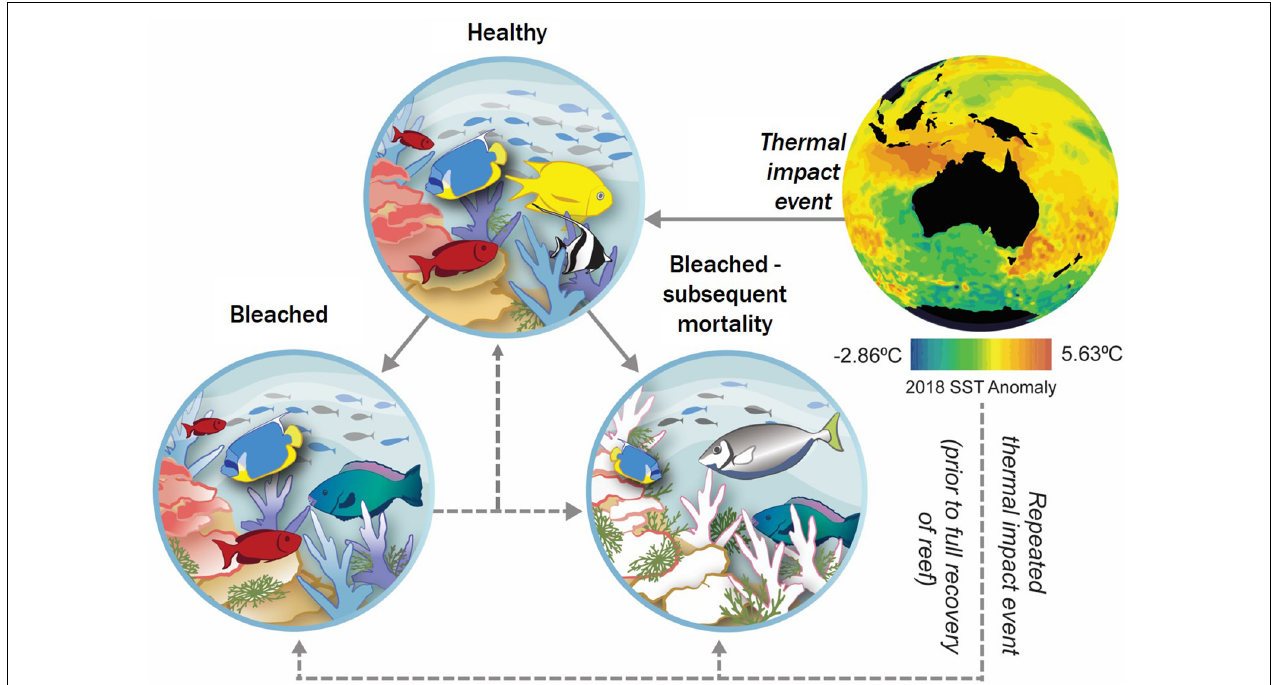
FIGURE 1 | Conceptual model of an acute heat event on coral reefs showing coral response pathways. Increased SST, depicted here by the mean annual 2018 SST anomaly (NOAA Coral Reef Watch, 2018), places pressure on coral reefs. Three major outcomes may result (Lough et al., 2018); these include (I) negligible effect – corals are able to maintain structure and function with little to no bleaching present; (II) bleaching – corals are affected by bleaching in areas, reef structure and function is still possible; and (III) mortality – extensive bleaching is apparent resulting in mortality – diversity, structure, and function of reef compromised. Re-bleaching may occur if the reef is subjected to subsequent thermal stress prior to baseline conditions being recovered. This may result in a negligible effect compared to post primary bleaching baseline, or further bleaching. (SST – source: NOAA Coral Reef Watch,